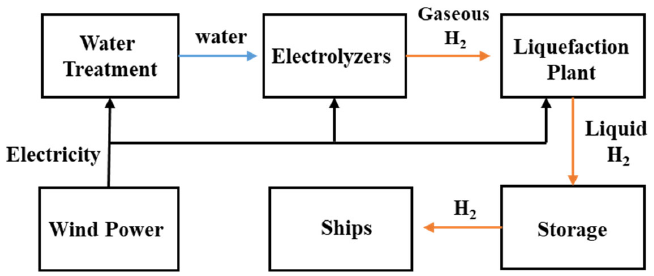
Figure 3. O ff shore lique fi ed hydrogen production and ship refueling plant [145]. Figure 3. Offshore liquefied hydrogen production and ship refueling plant [145]. Compared with green hydrogen, grey hydrogen is still more cost-effective